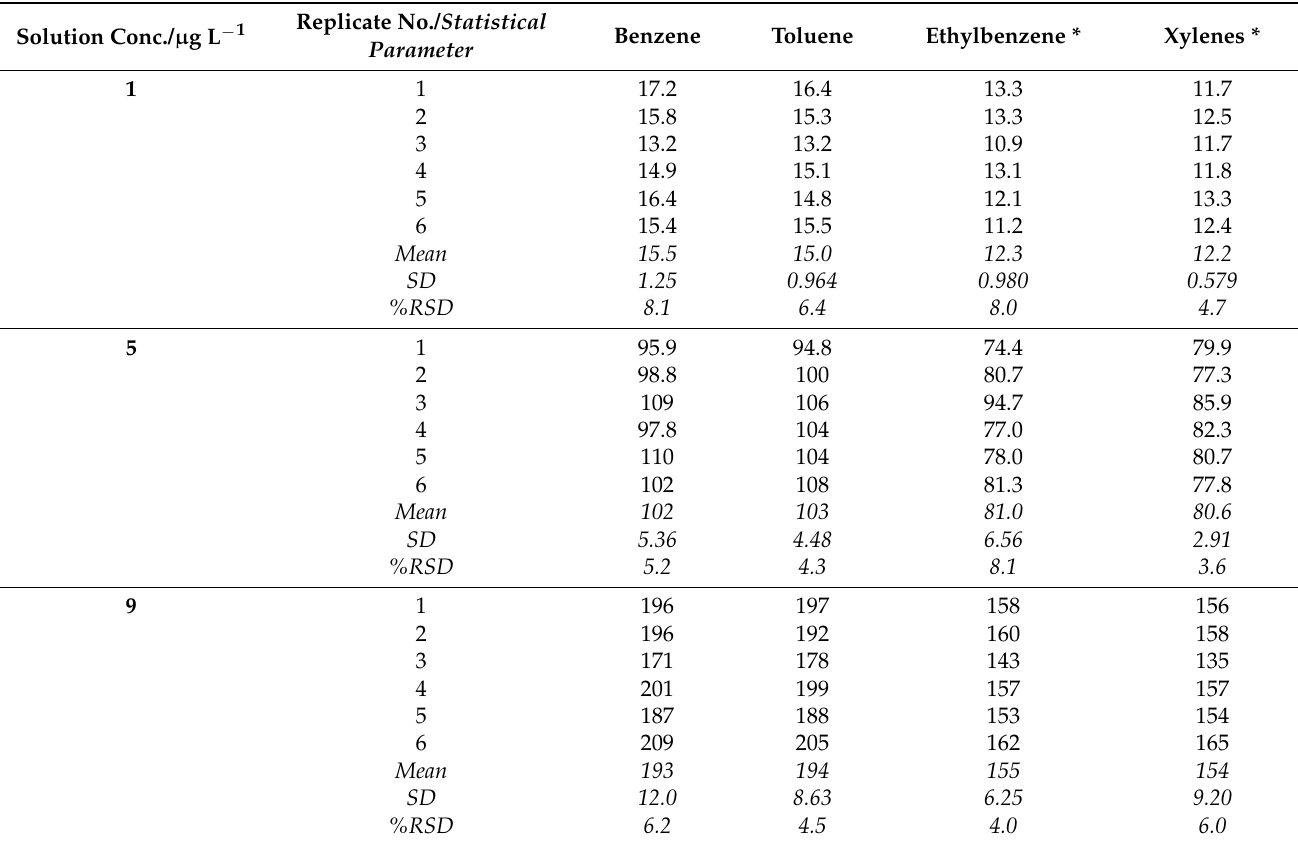
Table 6. Precision data for BTEX at solution concentrations of 1, 5, and 9 µ g L − 1 . Reported data, mean, and standard deviation (SD) are shown in ppbV (headspace), while RSD is shown as a percentage.